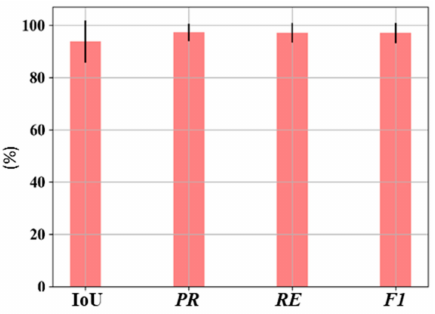
Figure 8. Statistical analysis of DeeperLabC on the validation set.